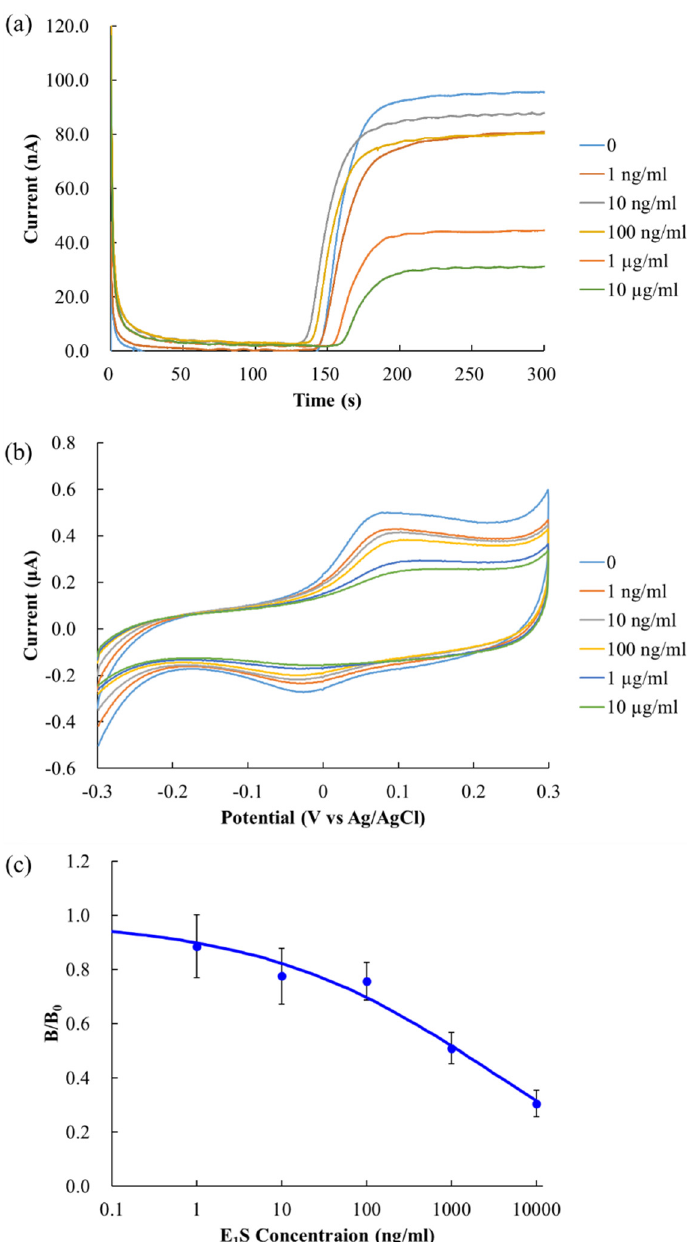
Figure 4. Results of electrochemical immunochromatography for E 1 S. ( a ) Chronoamperogram at the applied potential of 0.15 V vs Ag / AgCl. ( b ) Cyclic voltammogram at the incremental potential of 1 mV and scan rate of 50 mV / s. ( c ) Calibration curve (n = 3). The vertical axis of the graph shows B / B 0 , where B and B 0 are the electrochemical currents at 250 s of chronoamperogram for each sample and blank, respectively. Error bars represent standard deviations.